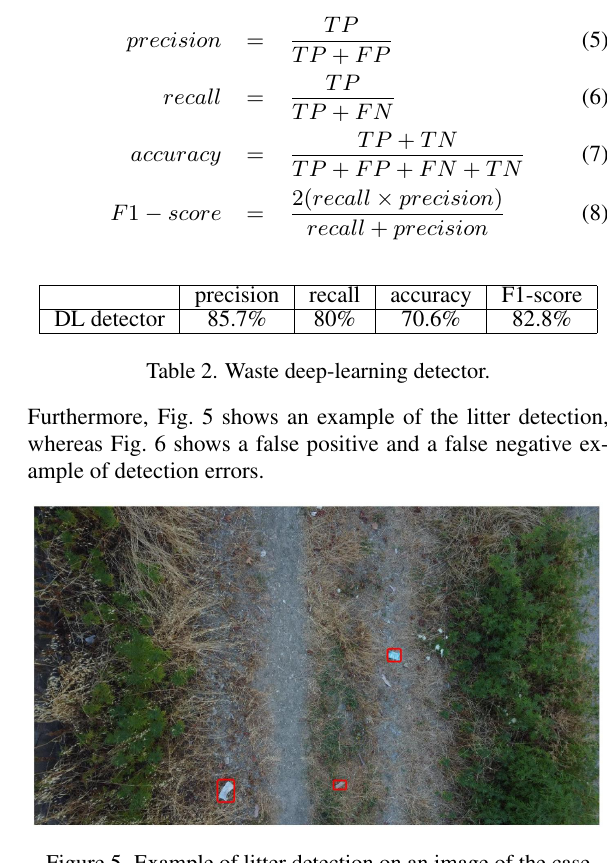
Figure 5. Example of litter detection on an image of the case study dataset.